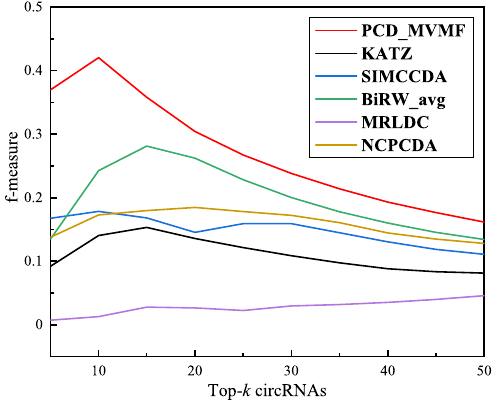
Fig. 6 Average f-measure of the test set at each Top- k position on querying diseases.